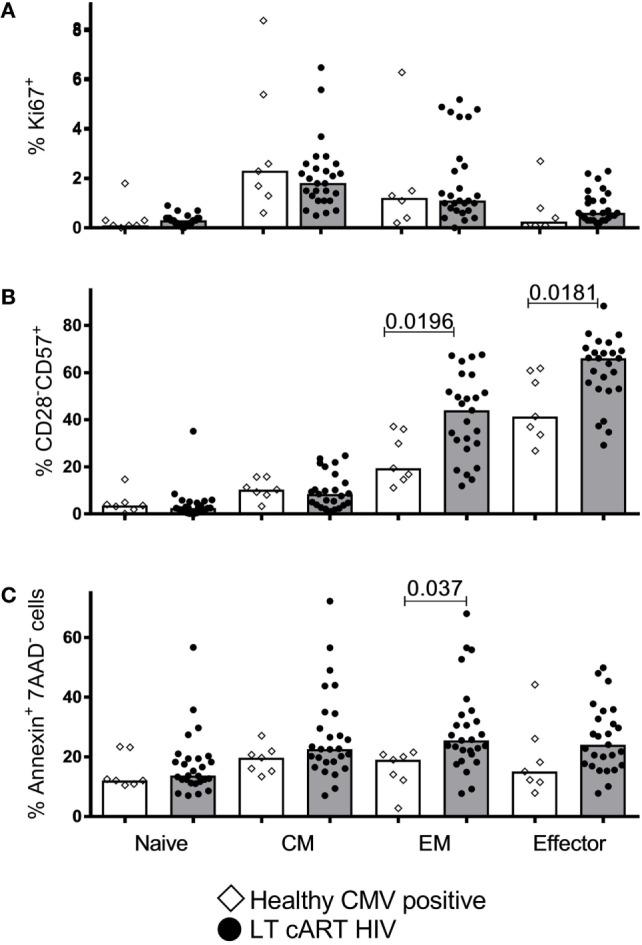
T-cell proliferation, senescence, and apoptosis. Percentages of (A) proliferating (Ki67+), (B) senescent (CD28−CD57+), and (C) apoptotic (AnnexinV+7AAD−) CD8+ T-cells in the different subsets in human immunodeficiency virus (HIV)-infected individuals on long-term combination anti-retroviral treatment (cART) (filled circles) compared to cytomegalovirus (CMV)+ healthy age-matched controls (open diamonds). Bars depict medians. Comparisons between data from HIV-infected individuals and healthy individuals were based on a Mann–Whitney U-test. All (uncorrected) P-values of <0.05 are provided in the figure.